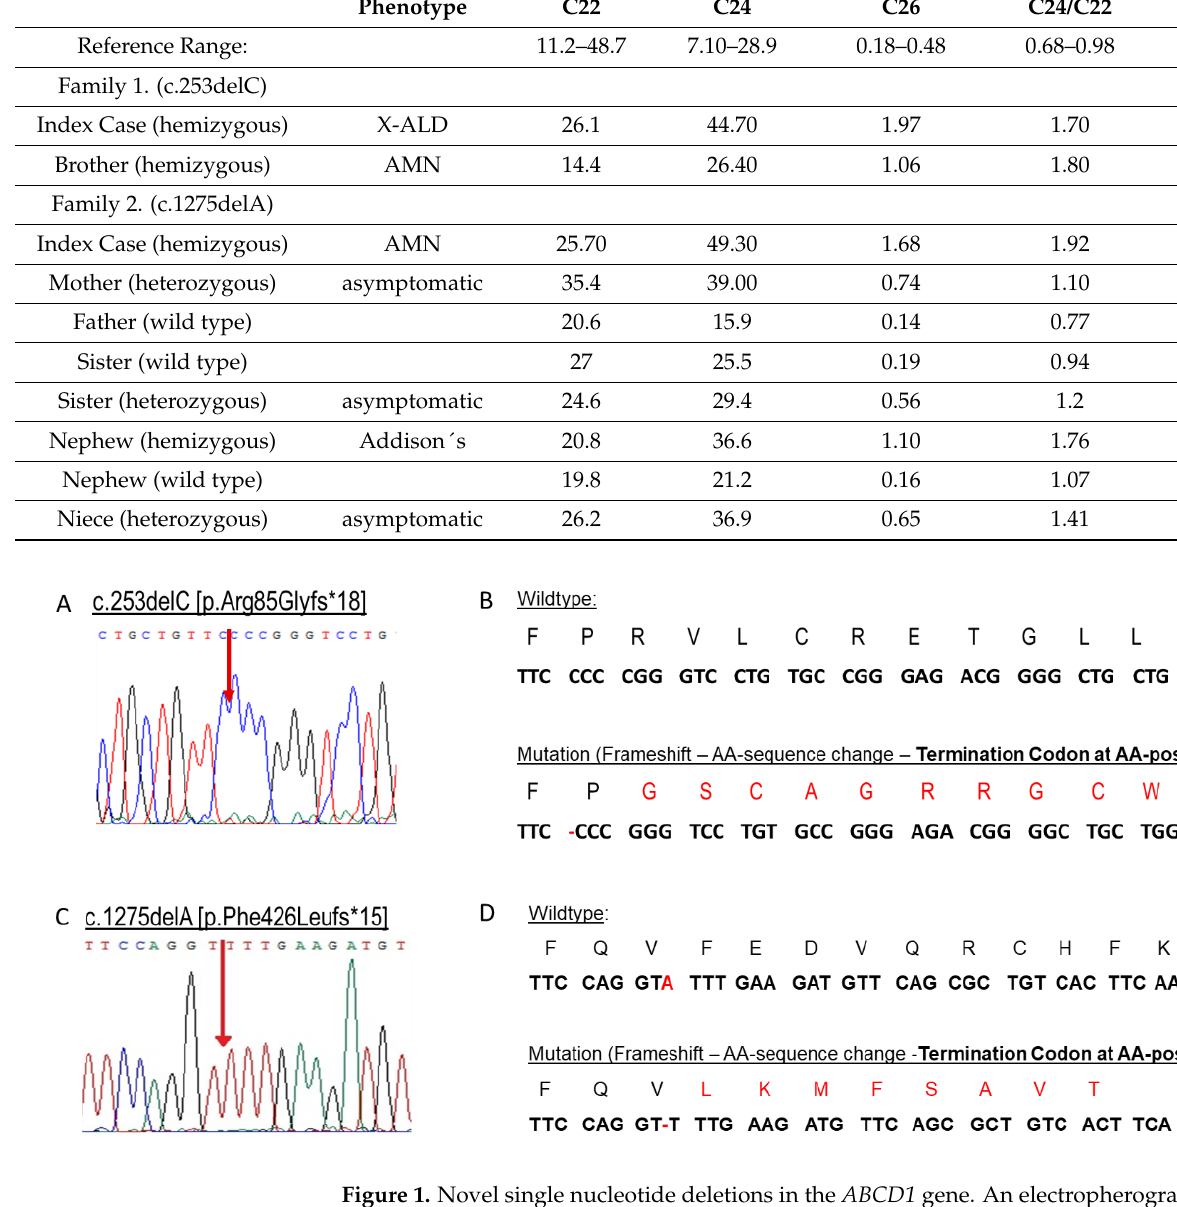
Figure 1. Novel single nucleotide deletions in the ABCD1 gene. An electropherogram after Sanger sequencing showing a sequence change in the index patient from family 1 ( A ) and from family 2 ( C ) and the resulting amino acid sequence change ( B ) and ( D ), respectively.